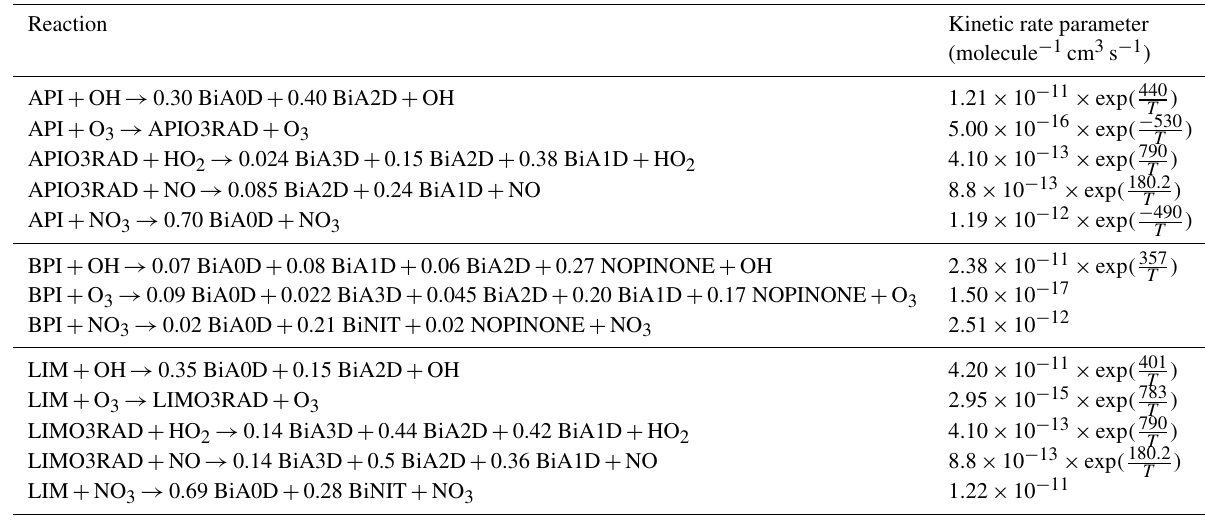
Table 6. Reactions leading to SOA formation ∗ from α -pinene (referred to as API), β -pinene (referred to as BPI) and limonene (referred to as